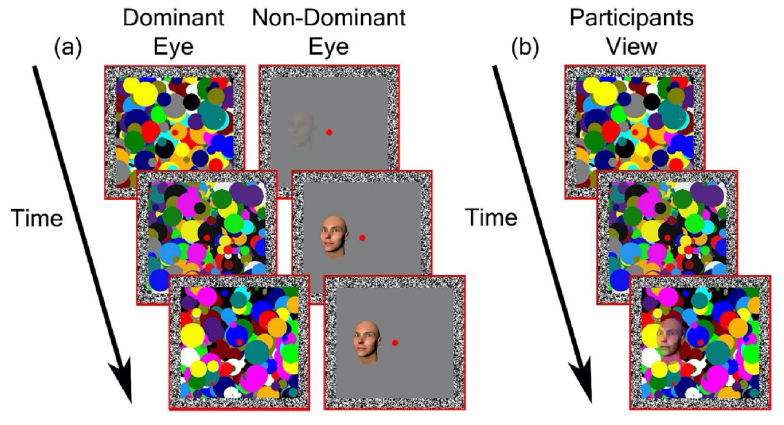
Figure 4. ( a ) A schematic of an example CFS trial. A high contrast flashing mask was presented to the participant’s dominant eye, while a face stimulus (here Standard Direct) was presented to the non-dominant eye. ( b ) A schematic example of a participant’s view during the task. The binocular presentation results in the temporary suppression of the face stimulus from conscious awareness. Participants are instructed to respond as quickly and as accurately as possible when any aspect of the face becomes visible.